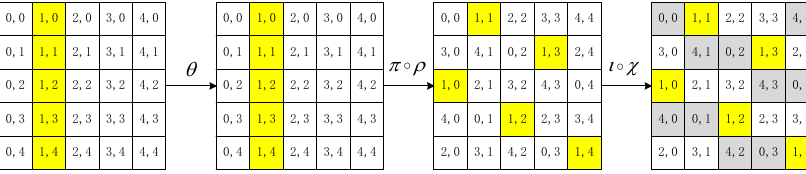
Figure 5: 1-Round Linear